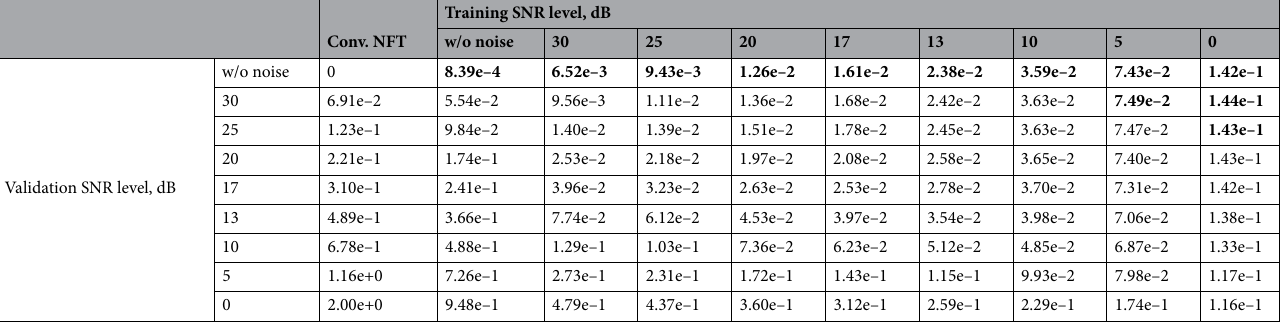
Table 1. Comparison of the NFT-Net performance against the conventional NFT in the computation of coefficient r (ξ) . The table presents the results for the optimised NFT-Net architecture from Fig. 3. The values in the cells show the error value (4) for each specific pair of training and validation sets SNR. The bold cells correspond to the cases when the accuracy of the NFT-Net nonlinear spectrum restoration is lower than that of fast NFT, i.e. the NN does not denoise the signal well, while the white cells correspond to the cases when the accuracy of the continuous NF spectrum rendered by the NFT-Net is higher, i.e. the NN effectively denoises the